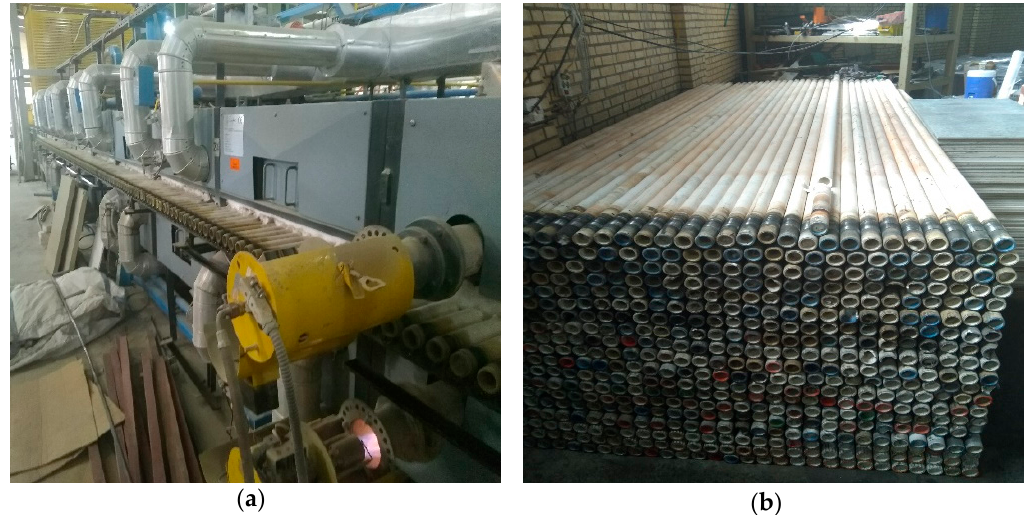
Figure 1. The application of roller alumina in tile manufacturing factories; ( a ) ceramic roller kiln, ( b ) factory wastes.